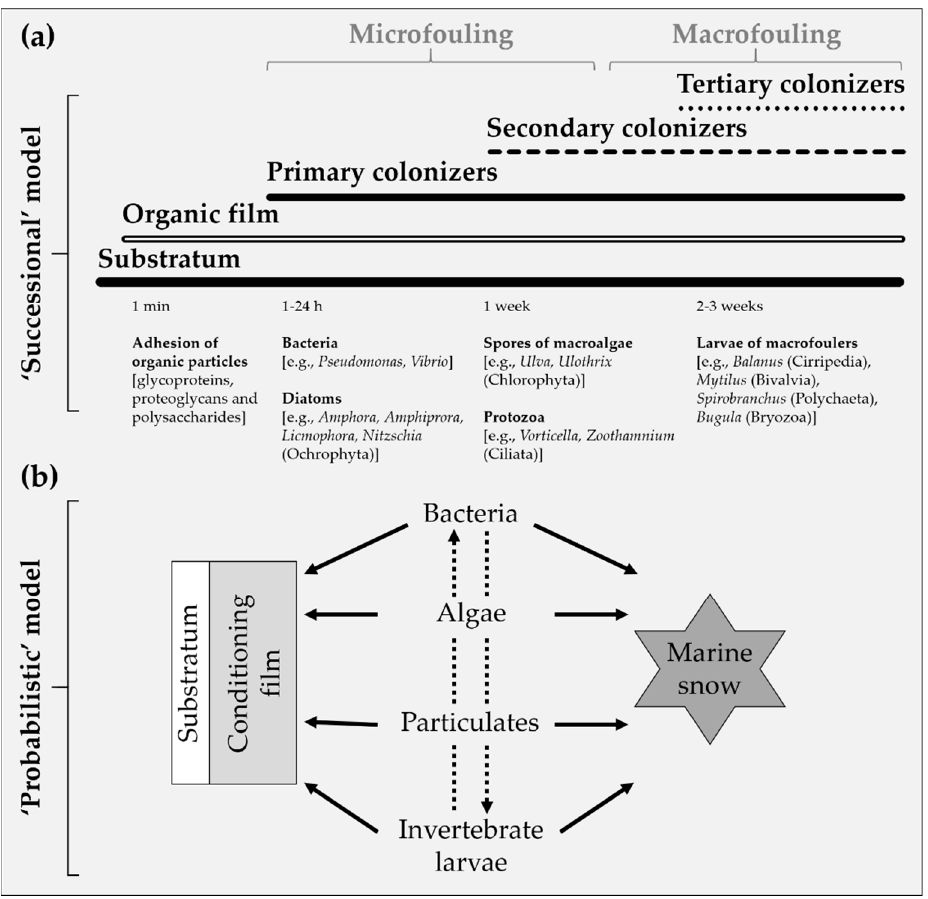
Figure 1. Schematic models of marine biofouling colonization: ( a ) “successional” model (after [13,14]); and ( b ) “probabilistic” model (after [16,17]).